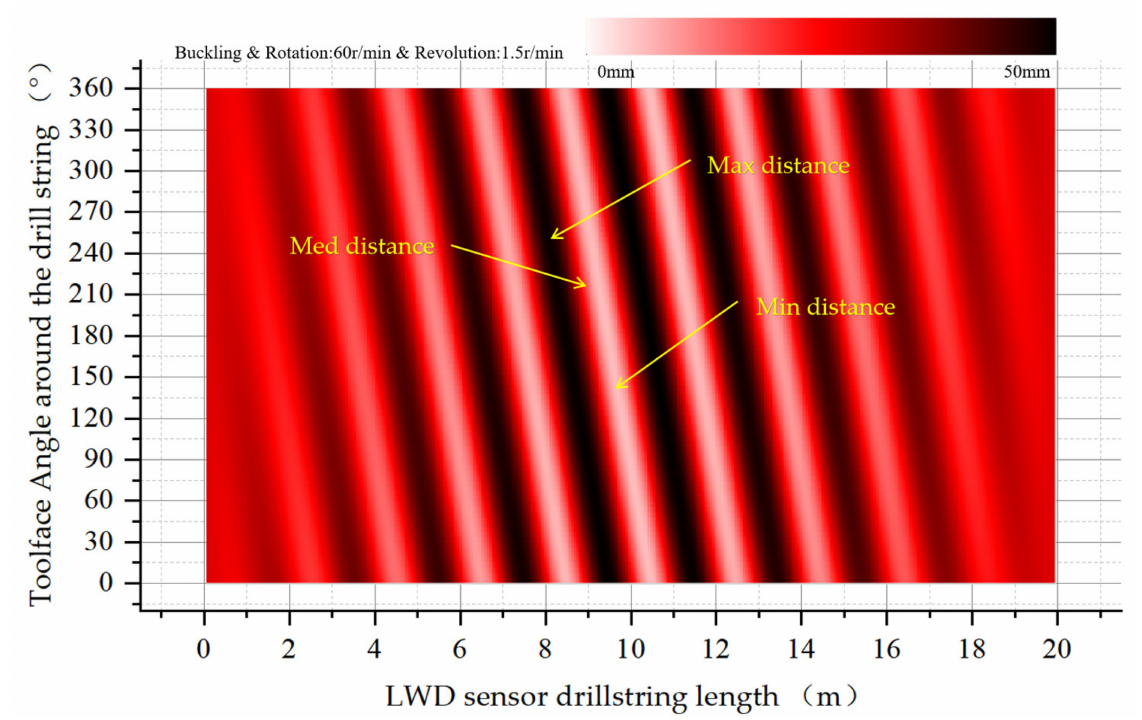
Figure 18. Eccentricity distribution along the drill collar surface after drill collar buckling with a revolution of 1.5 RPM.